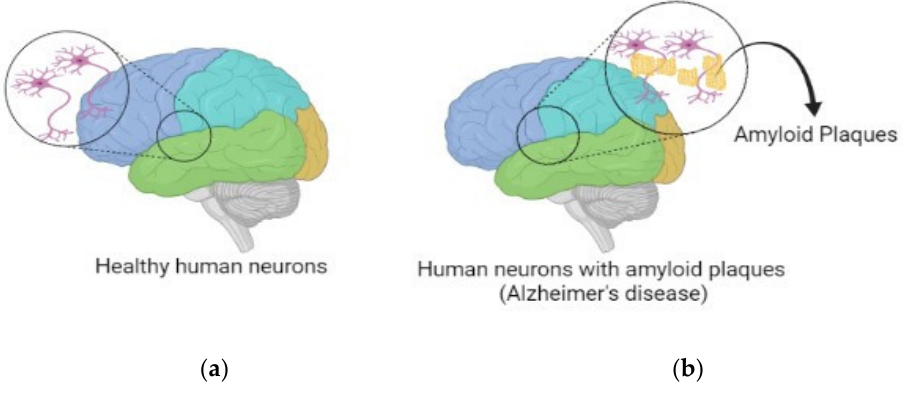
Figure 1. Human brains having ( a ) healthy neurons ( b ) amyloid plaques in neurons. Neurons pass the information signals through the cytoskeleton, which is made up of microtubules, and these microtubules are stabilized with the help of tau proteins.